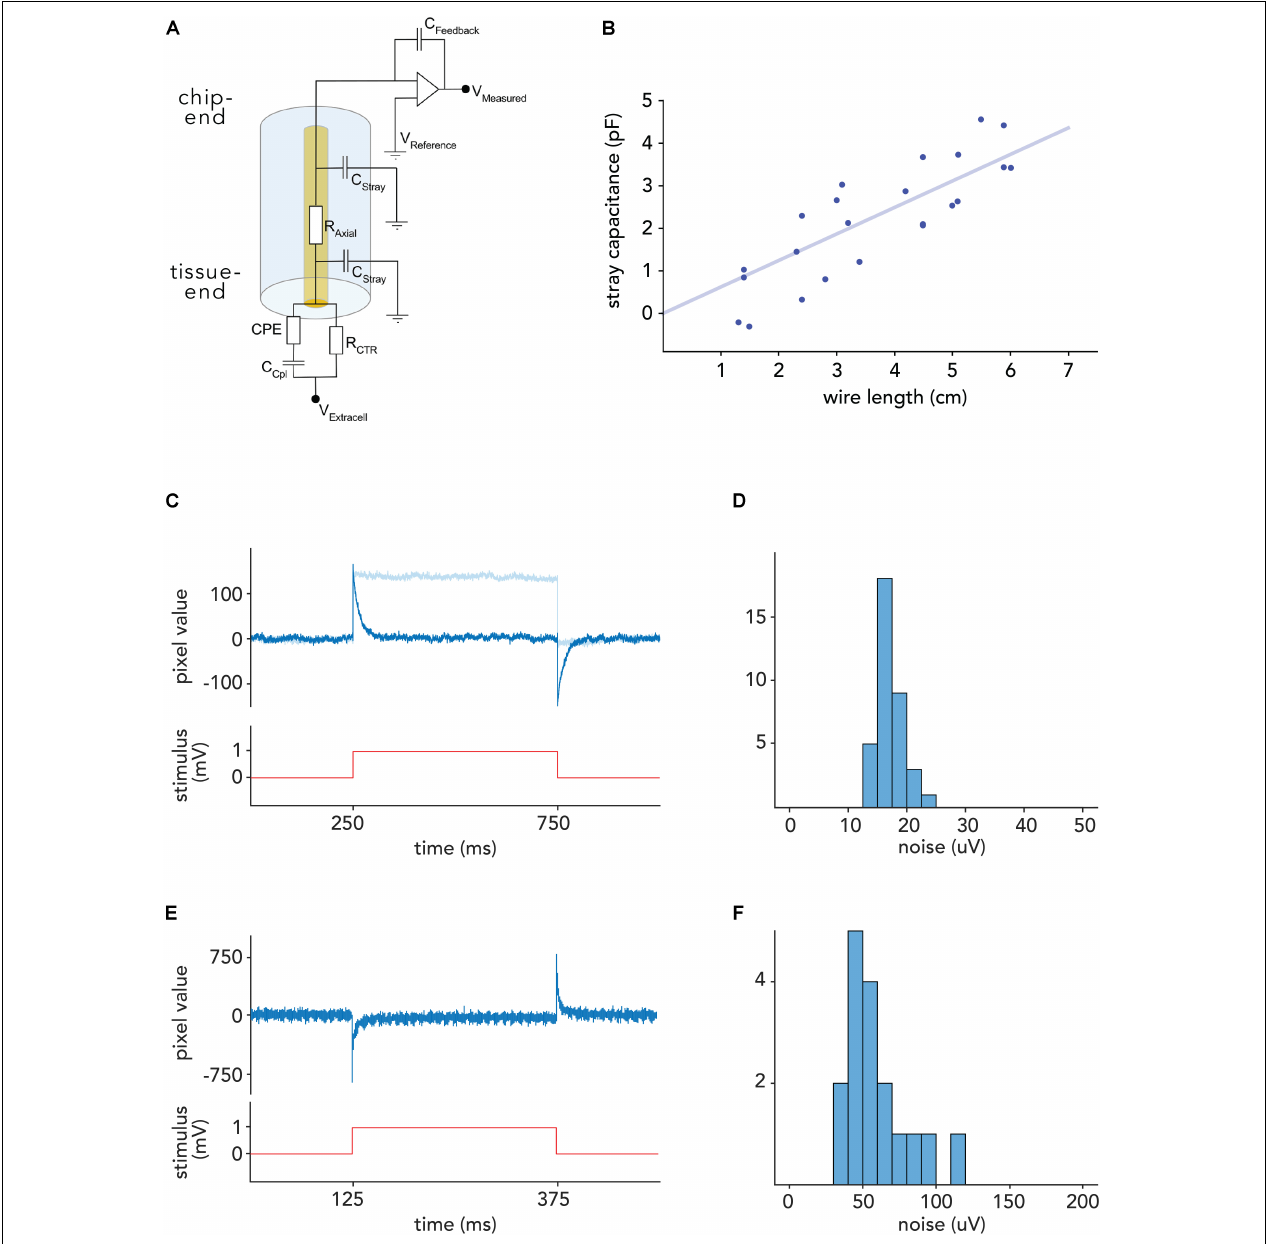
FIGURE 4 | Noise levels in voltage recordings with CHIME. (A) Electrical model of the recording configuration [depicted for a capacitive transimpedance amplifier derived from IR sensors (Vermeiren et al., 2009)]. The axial resistance of the metal core microwires (R Axial ) is low ( < 300 (cid:127) /cm). Signal loss is mainly determined by the stray capacitance (C Stray ). Signal amplitudes depend on the feedback capacitance of the amplifier (C Feedback ), and the degree of interfacial impedance, primarily the coupling capacitance (C Cpl ). (B) Stray capacitance for a glass/gold wire with outer diameter of 28.3 µ m and inner diameter of 1.1 µ m. Stray capacitance scales linearly with wire length and is low ( < 1 pF/cm) due to the high outer to inner diameter ratio. (C) Response of one pixel of a Mea1k switch-matrix based MEA (Müller et al., 2015) to a 1 mV voltage step applied to the bath, recorded through a connected electrode. On-chip high-pass filter: 300 Hz (dark blue), 1 Hz (light blue) (D) RMS noise level distribution in connected Mea1k pixels. (E) Voltage response of a Cheetah 640CL IR camera ROIC pixel in arbitrary units (Neys et al., 2008). Due to the inverting amplifier circuit, responses are reversed. (F) Noise level distribution in connected IR camera CMOS pixels.